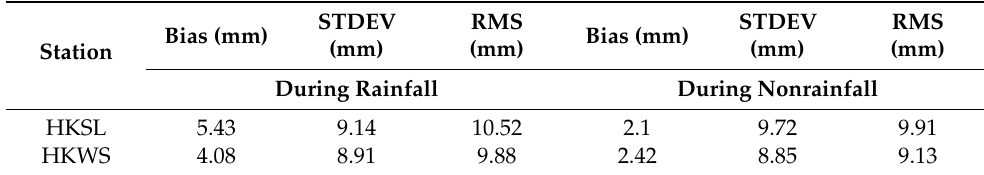
Table 5. Bias, STDEV, and RMS between PPP-ZTD and